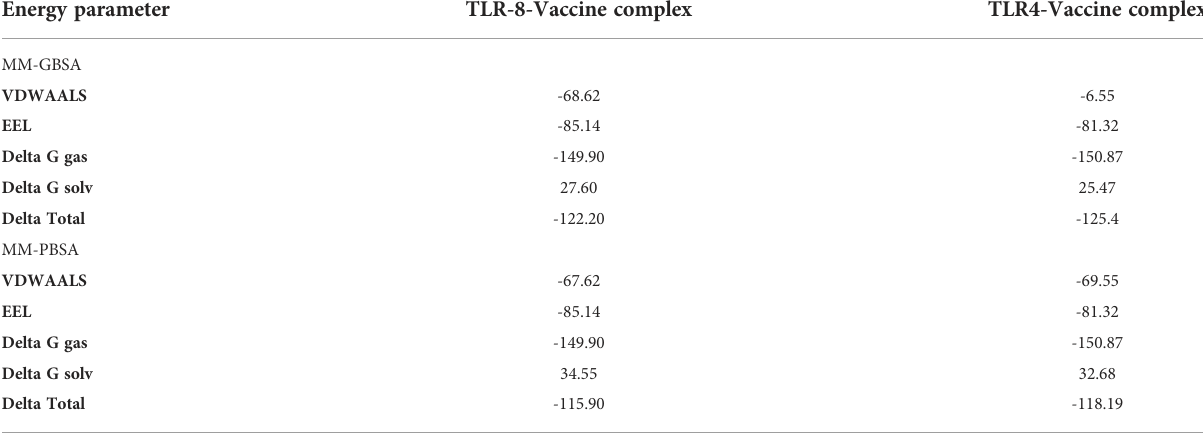
TABLE 5 Binding free energies calculation values and parameters. Energy